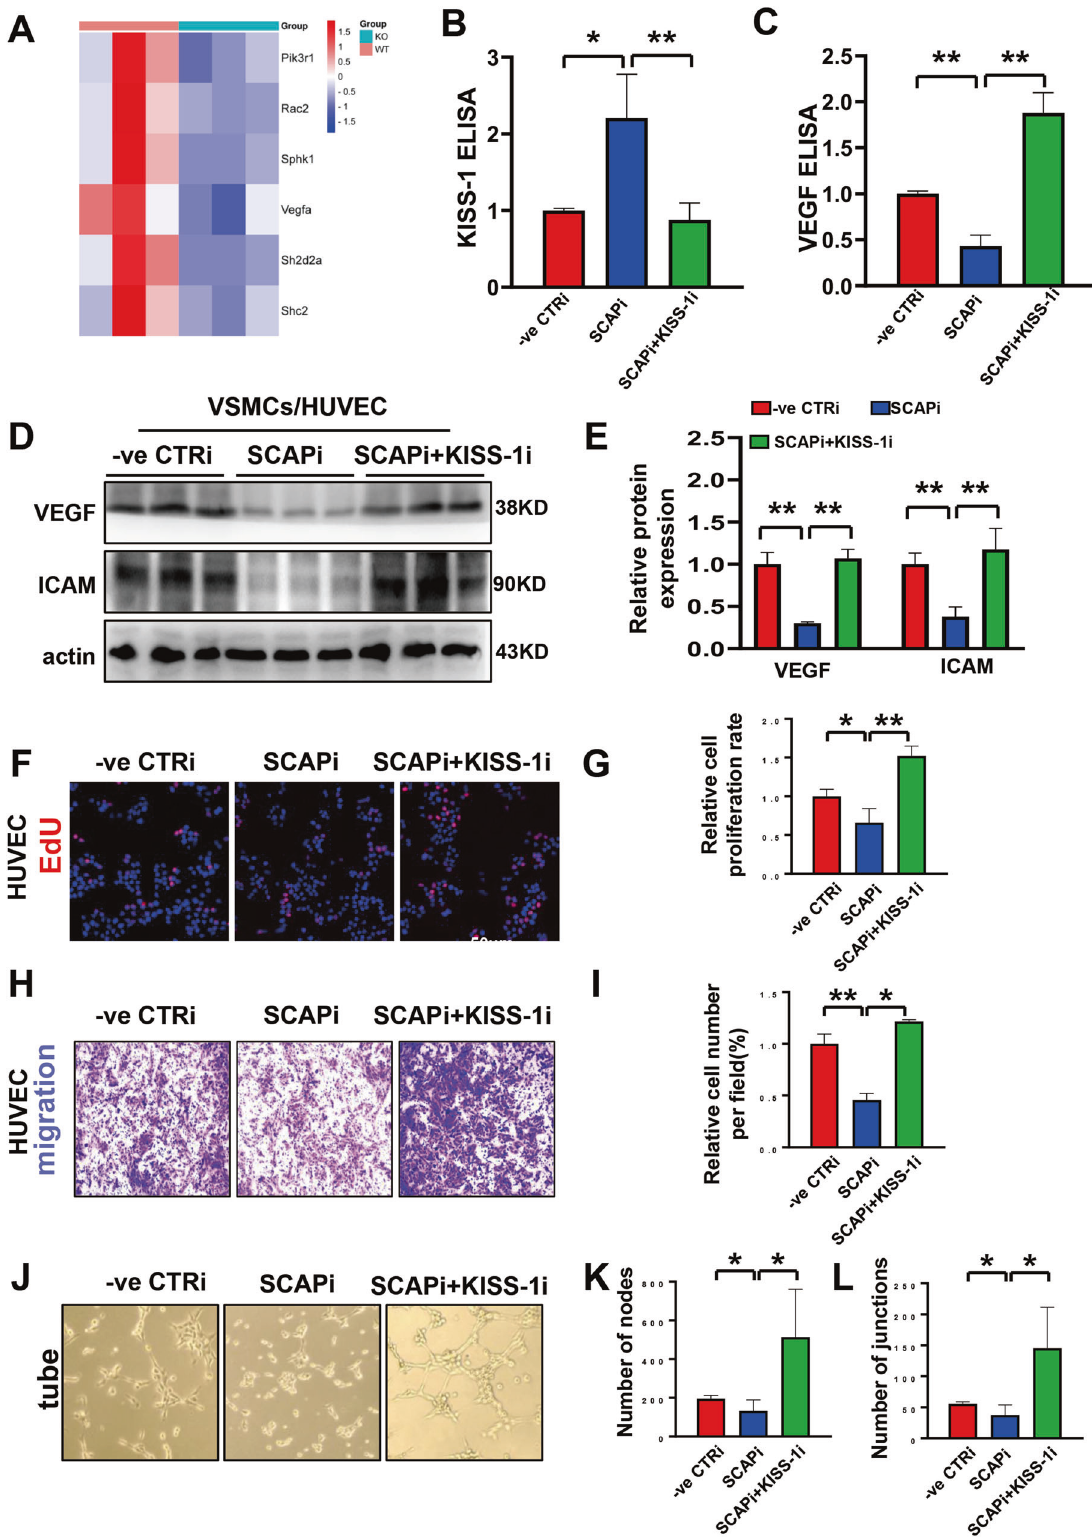
complex process involving many different cells and signal pathways. Initially, endothelial cells form the lumen, then recruit smooth muscle cells to form an elastic layer around the lumen and begin to construct a vascular matrix containing elastin to